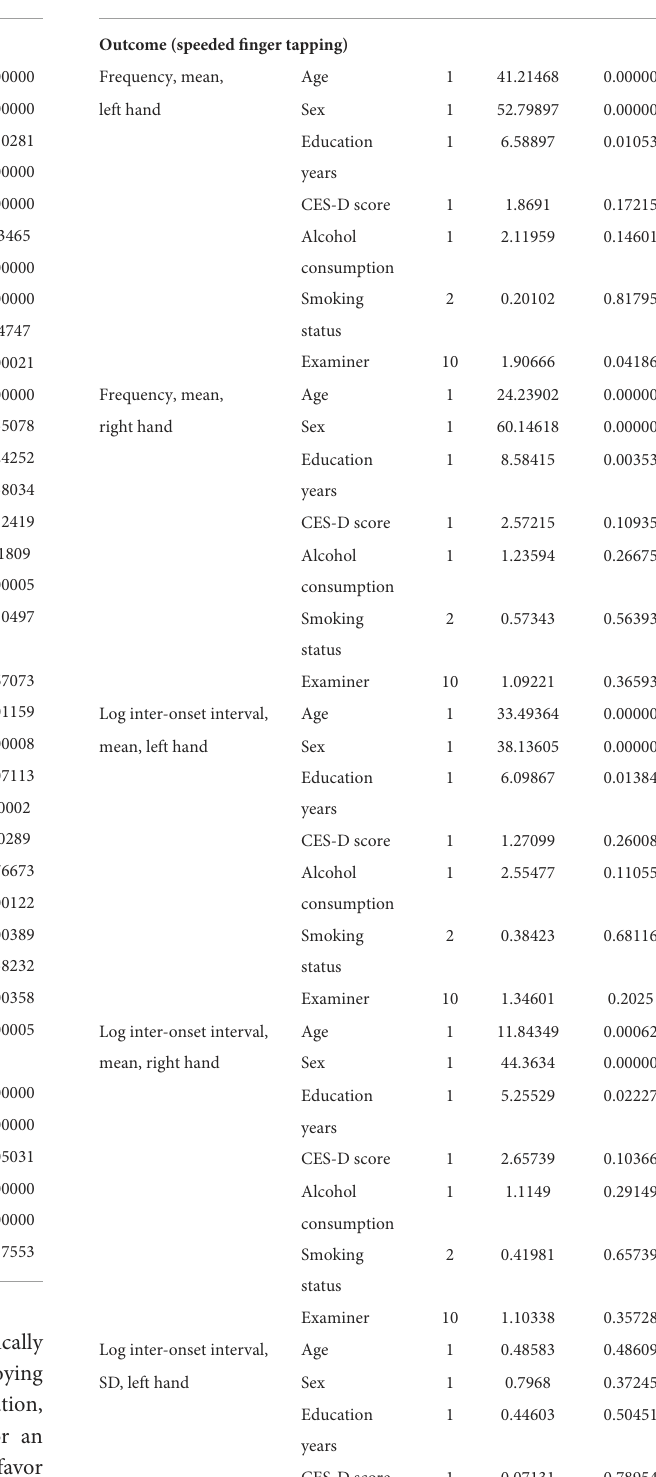
TABLE 8 Effects of individual explanatory variables, model 1. TABLE 9 Effects of individual explanatory variables, model